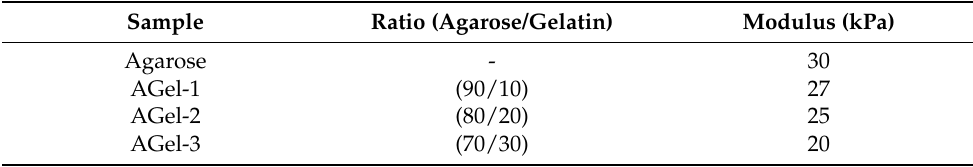
Table 1. Green composite